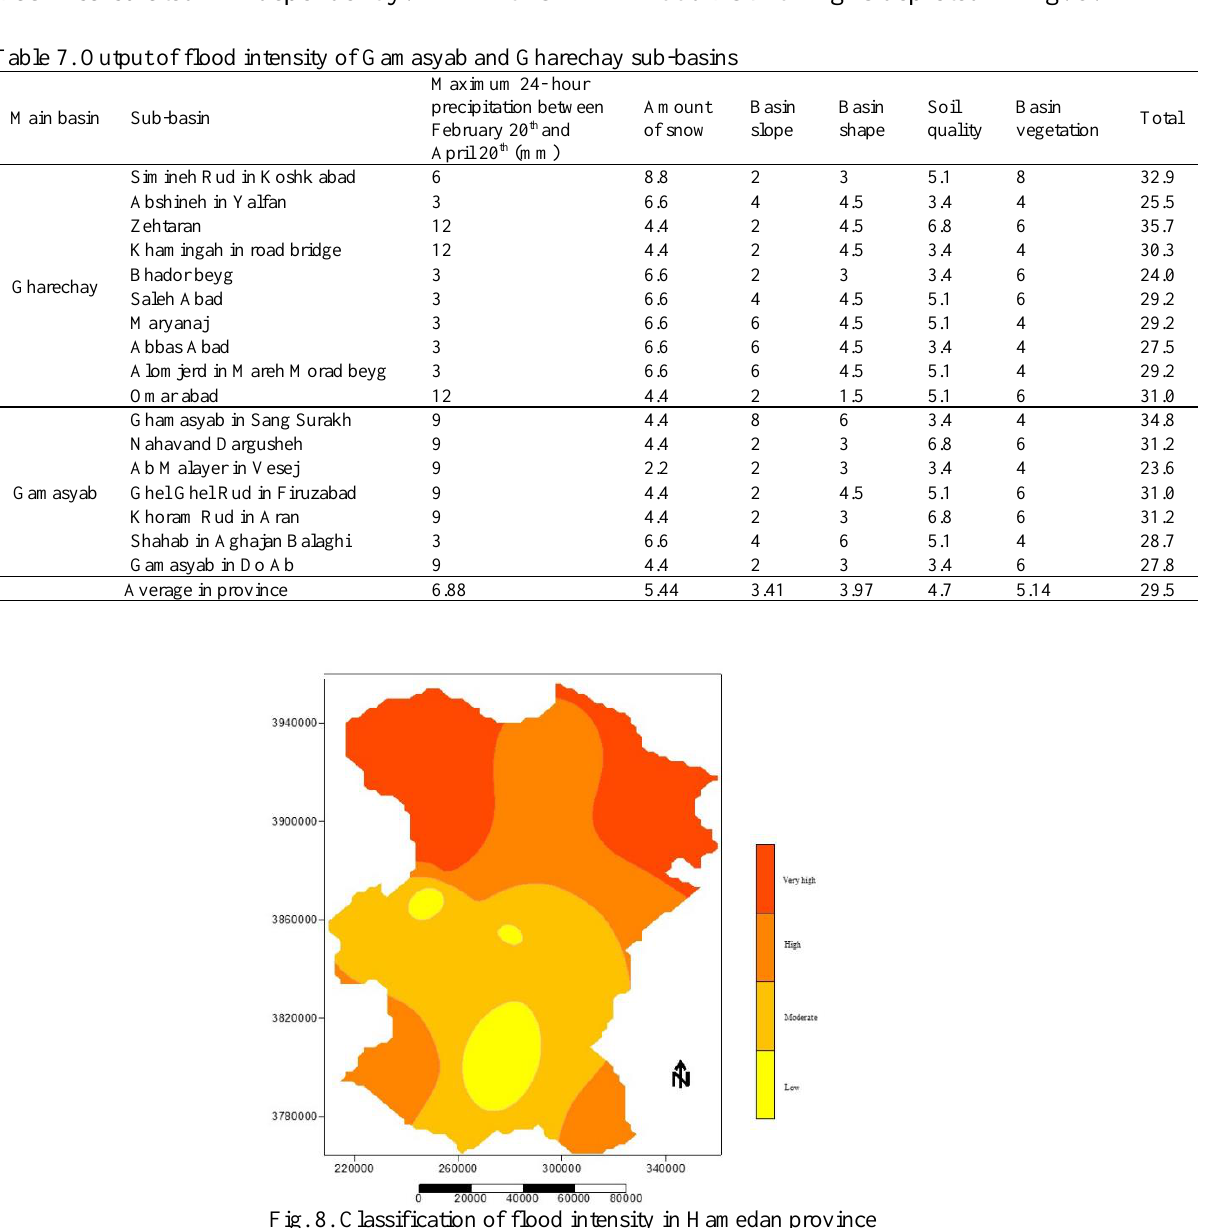
Table 7. Output of flood intensity of Gamasyab and Gharechay sub-basins Main basin Sub-basin